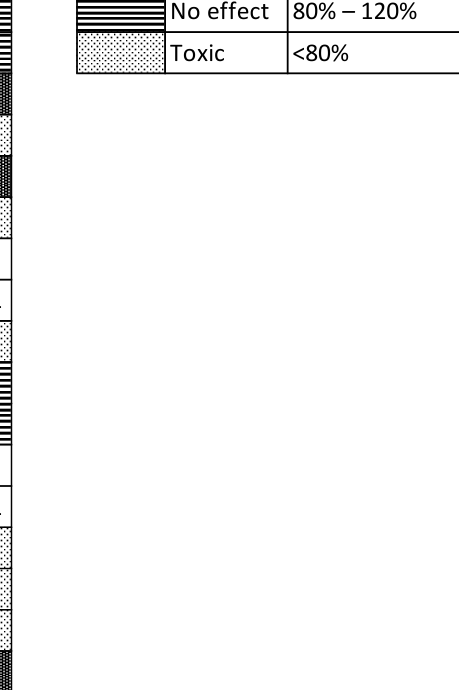
Figure 4. Effects of the different types of sulfated/sulfonated compounds on iPSC proliferation. Based on data obtained by the same method as in Figure 3, the effects of polysaccharides ( A ), oligo- saccharides ( B ), and synthetic polymers ( C ) on iPSC culture in E8 medium with Matrigel at 25 and 250 ng/mL were assessed. The percentage cell proliferation caused by each type of material is indi- cated. Microsoft Excel for Microsoft Apps for Enterprise was used for the preparation of the figure.